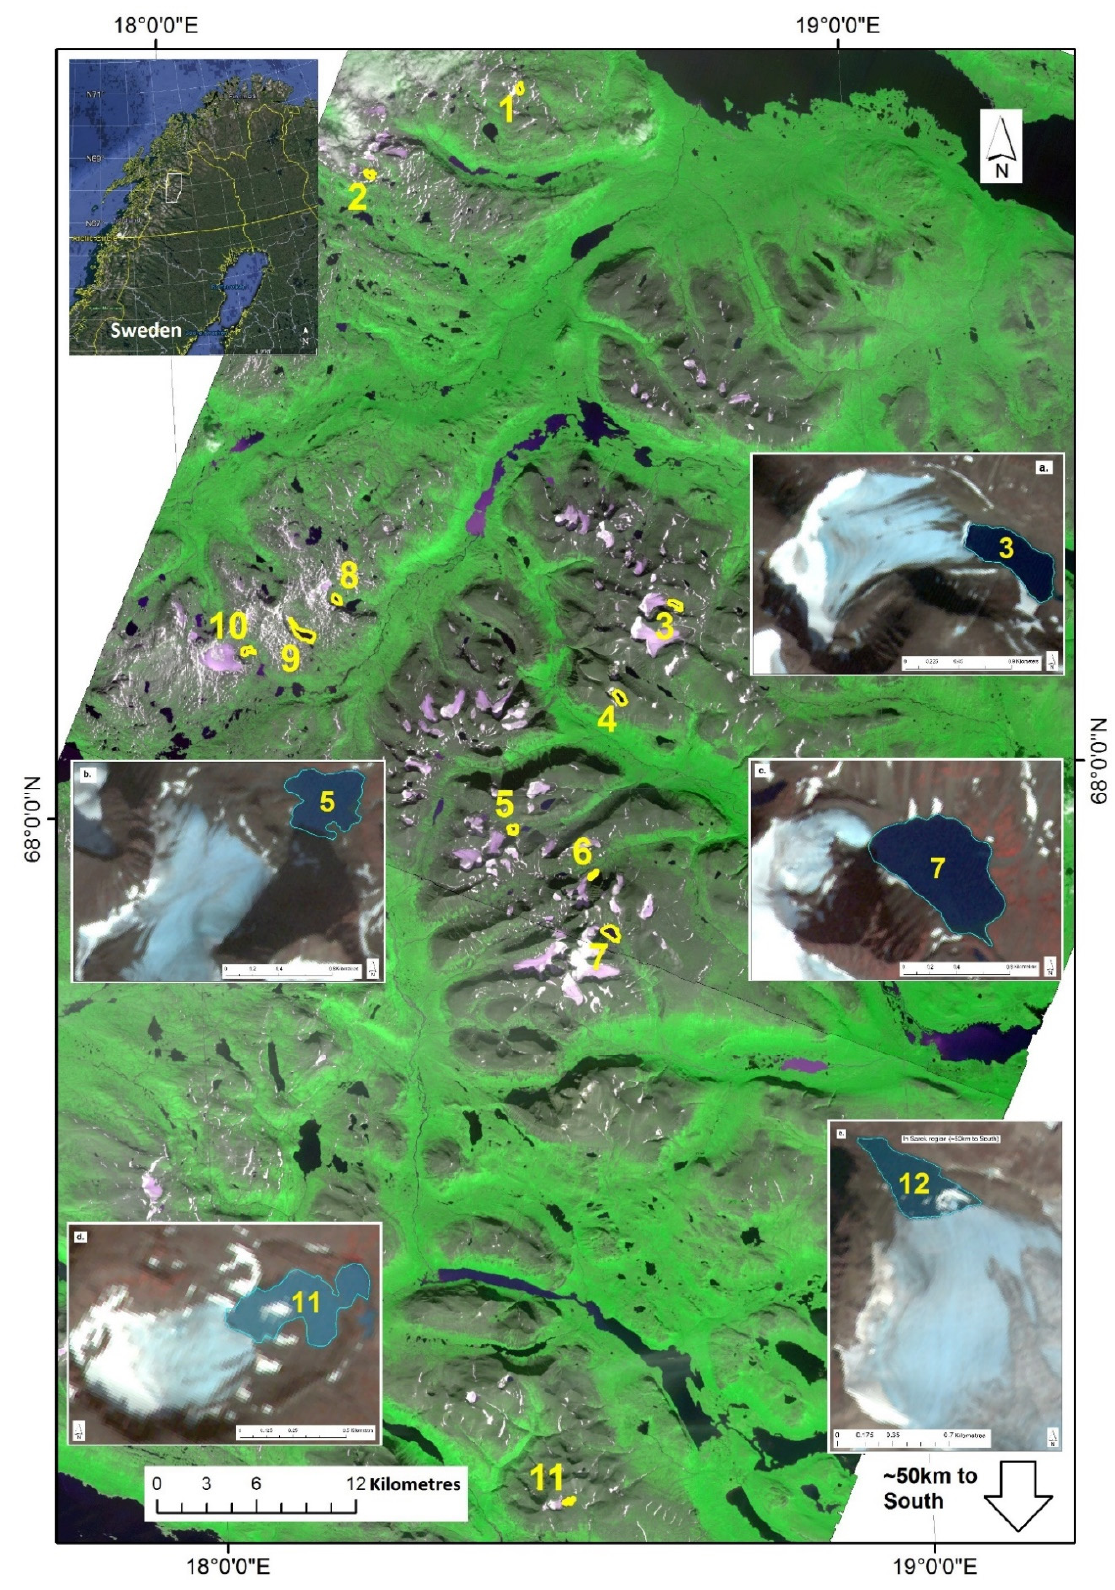
Figure 2. ASTER satellite composite (green, red, and NIR) image showing the locations of the 12 proglacial lakes (Arctic Sweden) with a sufficient area to have sufficient pixels for surface temperature analysis via the AST08 temperature product. Note that lake 12 is situated ~50 km to the south in the area of